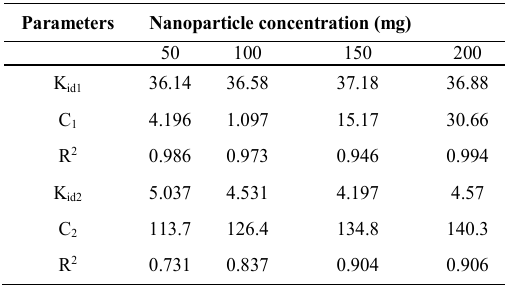
Table 4: Obtained values of Intra-particle diffusion model parameters Parameters